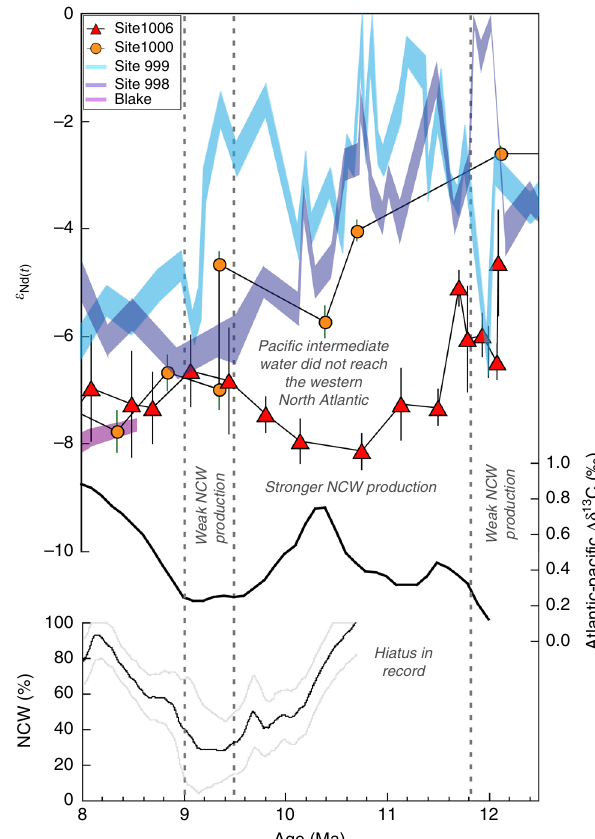
Fig. 4 Comparison of seawater Nd isotope records with estimates of Northern Component Water production. Seawater ε Nd(t) signatures of Caribbean and Western Atlantic sites (this study 10, 34 ) together with two different estimates of Northern Component Water (NCW) production based on δ 13 C gradients between the Atlantic and the Paci fi c (upper black curve, ref. 32 ; lower three curves showing NCW production (thin black curve) and ±1 sigma uncertainty (thin grey lines), with a hiatus and unreliable estimates before 10.7 Ma omitted, ref. 30 ) for the period between 12.5 and 8 Ma. Vertical dashed lines show episodes of weak NCW production when the ε Nd(t) records indicate strong Paci fi c-western North Atlantic through fl